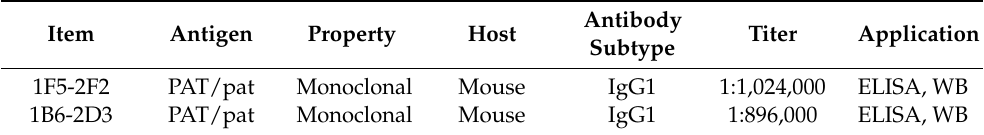
Table 2. Variable region sequence of Anti-PAT/pat mAbs.